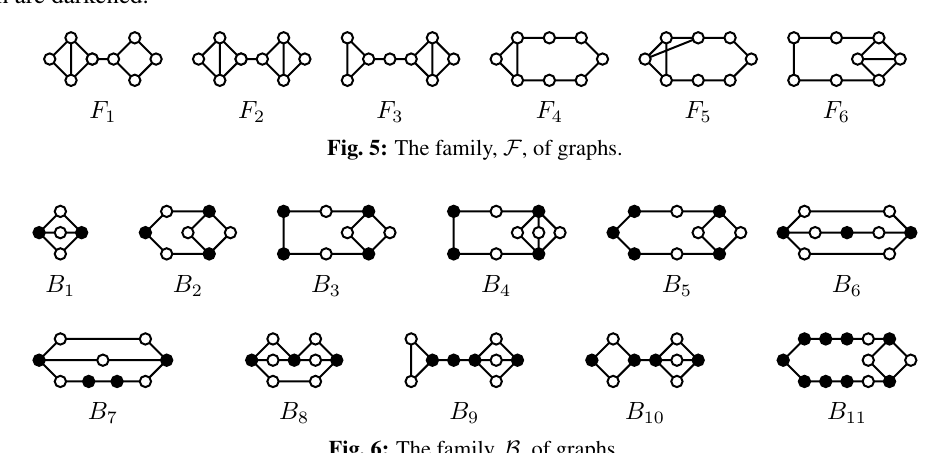
Fig. 6: The family, B , of